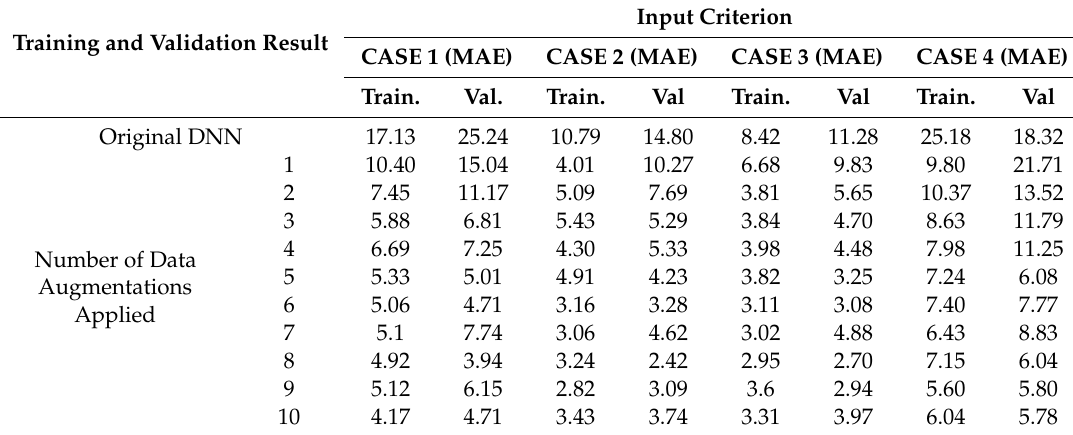
Table 6. Training and validation error with data augmentation.